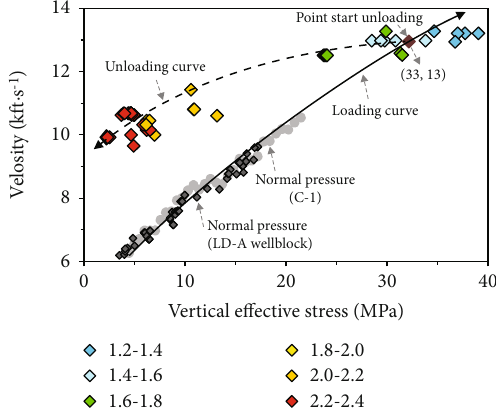
Figure 14: Crossplot of vertical e ff ective stress versus sonic velocity in LD-B Wellblock, showing the fi rst unloading point.